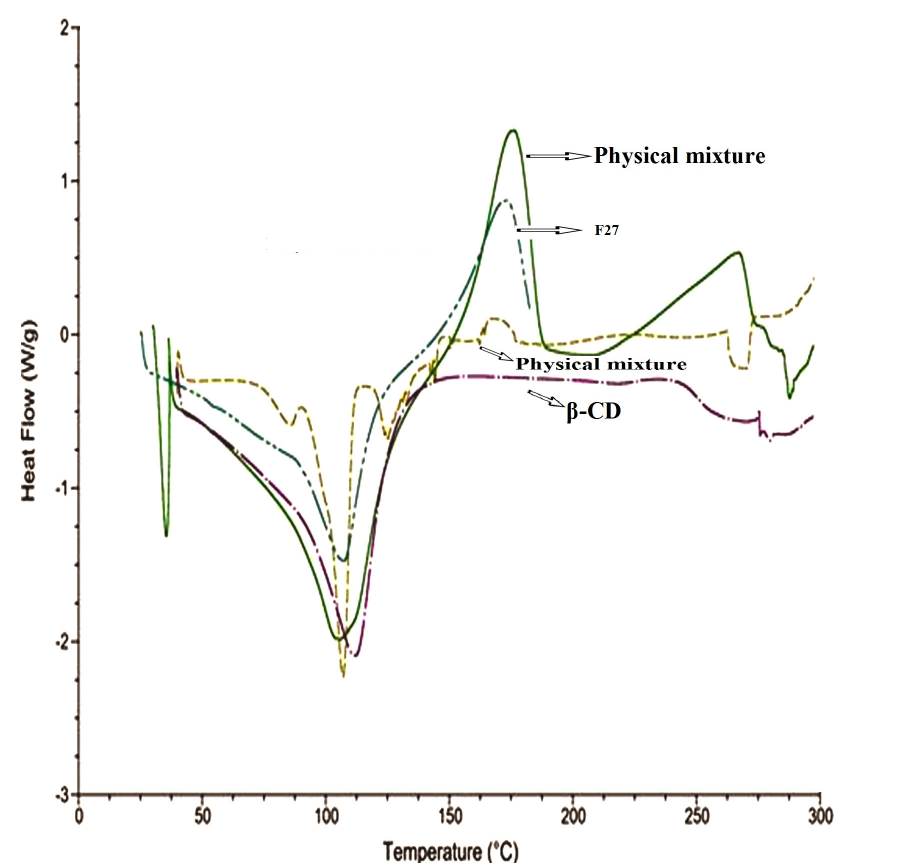
FIGURE 2 - DSC thermogram of ramipril; β-CD; physical mixture drug and β-CD, and F27 formulation.